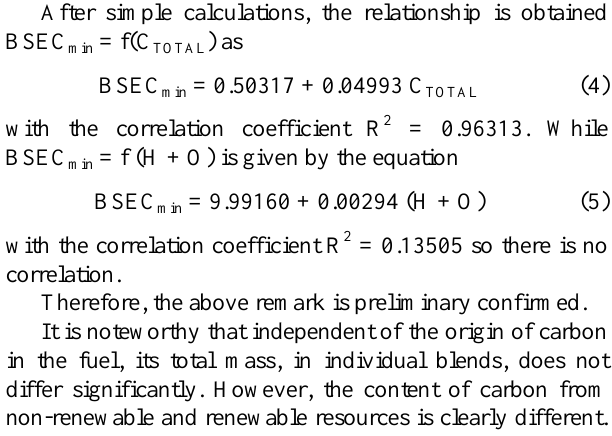
COMBUSTION ENGINES, 2023;192(1)